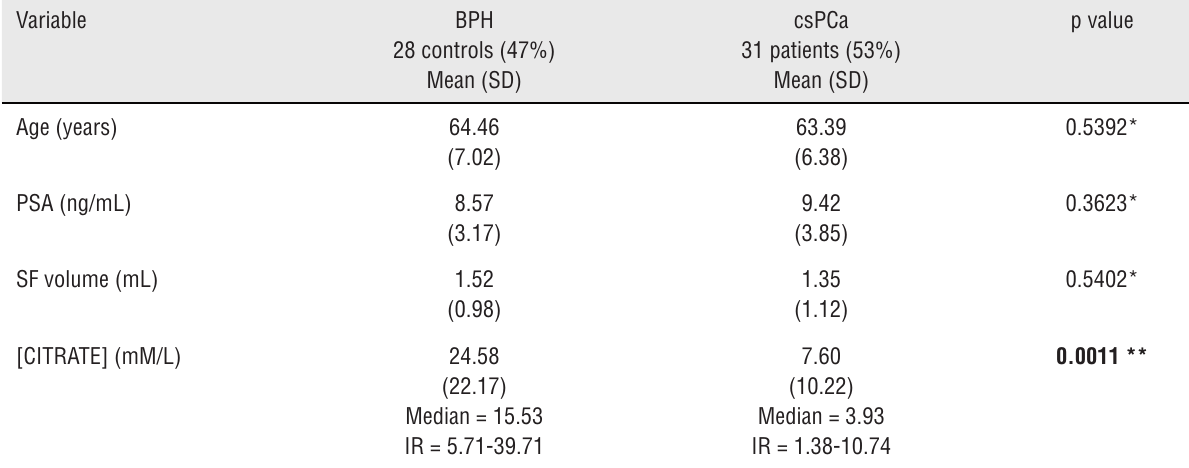
Table 2 - Comparison of age (years), PSA (ng/mL), seminal fluid volume (SF) (mL) and [CITRATE] (mm/l) in men with BPH and csPCa.